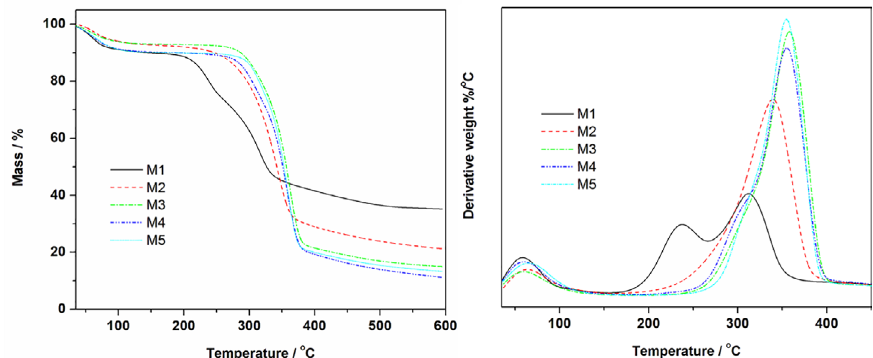
Figure 8. TG and DTG curves of the five methods used for the extraction of cellulose from sugarcane bagasse